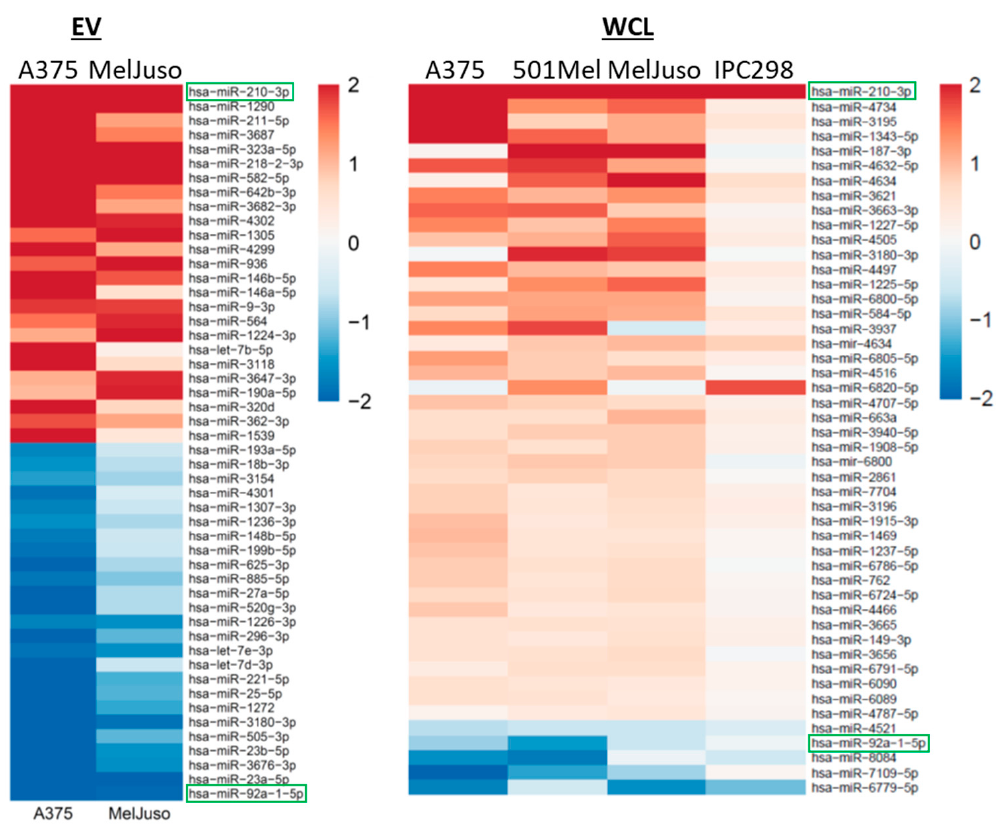
Figure 6. miRNA profiling of melanoma EVs and WCLs. Heatmap showing the top 25 miRNAs di ff erentially up- (red) or downregulated (blue) in A375 and MelJuso hEVs compared to nEVs (left) and regulated miRNAs in hWCLs compared to nWCLs in all four cell lines (right). Colours indicate the fold change in expression relative to normoxia (log2 scale). miRNAs found in both EVs and WCLs are framed in green.